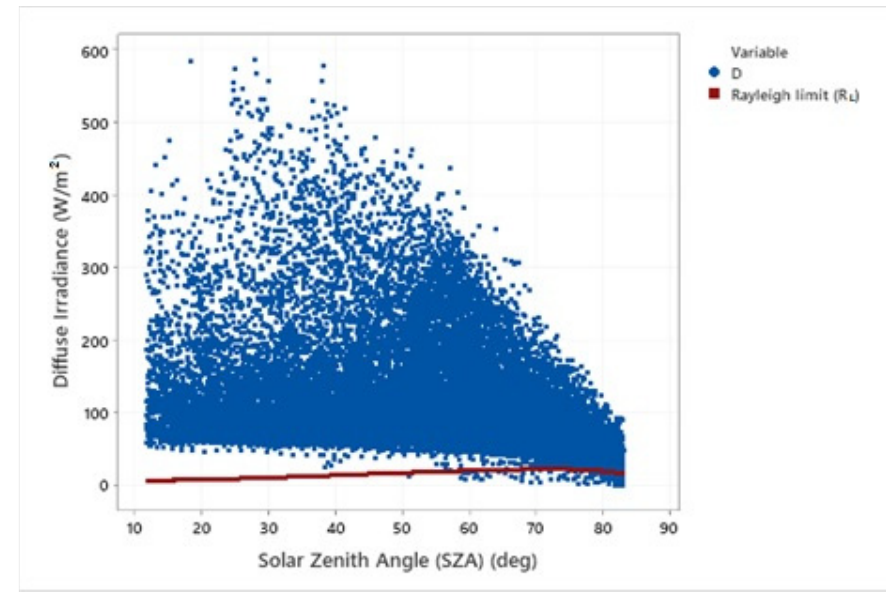
Figure 8. Comparison based on the Rayleigh limit for data points that have k d < 0.8 and G > 500 W/m 2